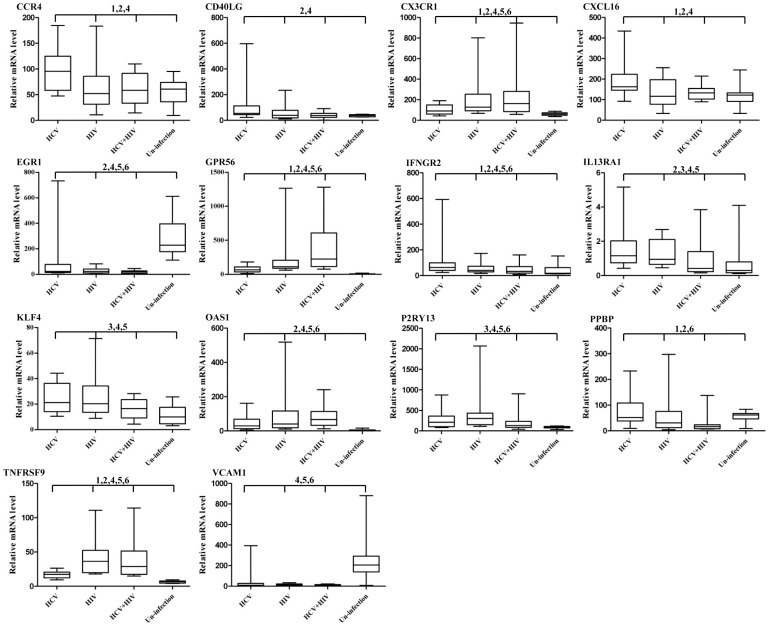
Validations of differentially expressed genes by quantitative real-time PCR.The mRNA levels of selected genes were measured in HCV-mono-infected, HIV-mono-infected, HIV/HCV-co-infected and uninfected individuals by quantitative real-time PCR. The relative mRNA value was calculated by the following formula: R = 2CT (GAPDH-X)*103, where X represents the CT value of each gene. Box-plot illustrated the medians with 25% and 75%. 1–6 represent comparisons between HCV infection and HIV infection, HCV and HIV/HCV co-infection, HIV and HIV/HCV co-infection, HCV infection and uninfection, HIV infection and uninfection, and HIV/HCV co-infection and uninfection with p<0.05, respectively.